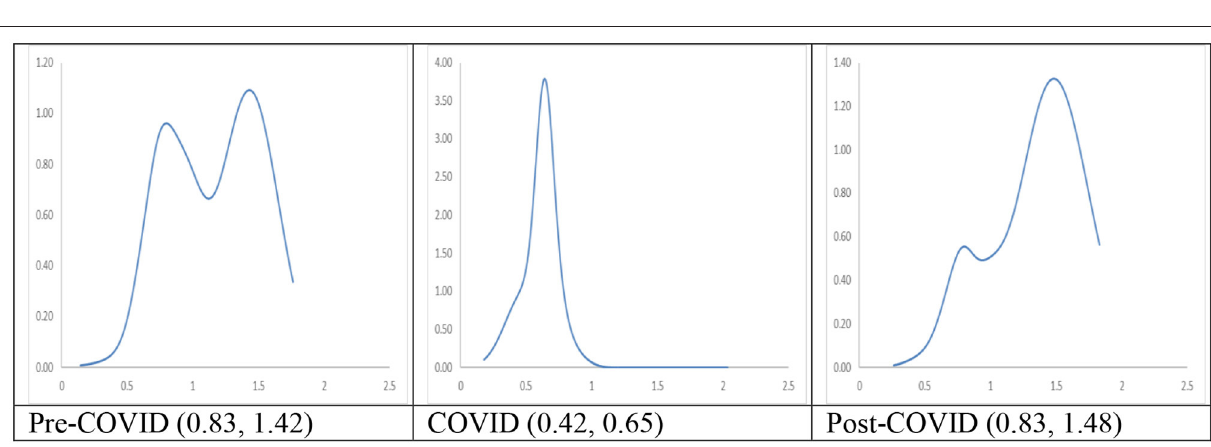
FIGURE 9 | Ergodic distributions for the RDIPC of all cities with short duration of Level I ERS. Source: authors’ calculation. N.B. The vertical axis indicates the density of probability, the horizontal axis indicates RDIPC values, and the value of the peaks are in